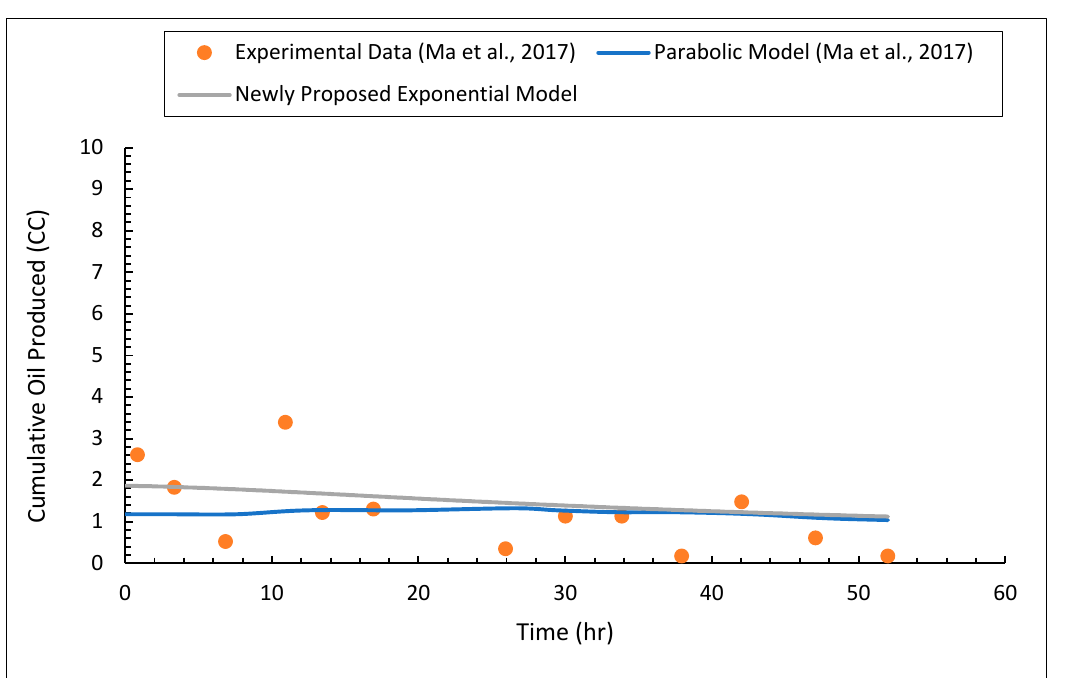
Figure 27. Comparison of the oil production rate estimated by the newly proposed exponential model, experimentally measured oil production rate [3], and oil production rate estimated by the parabolic model proposed by Ma et al. [3] in test #3.